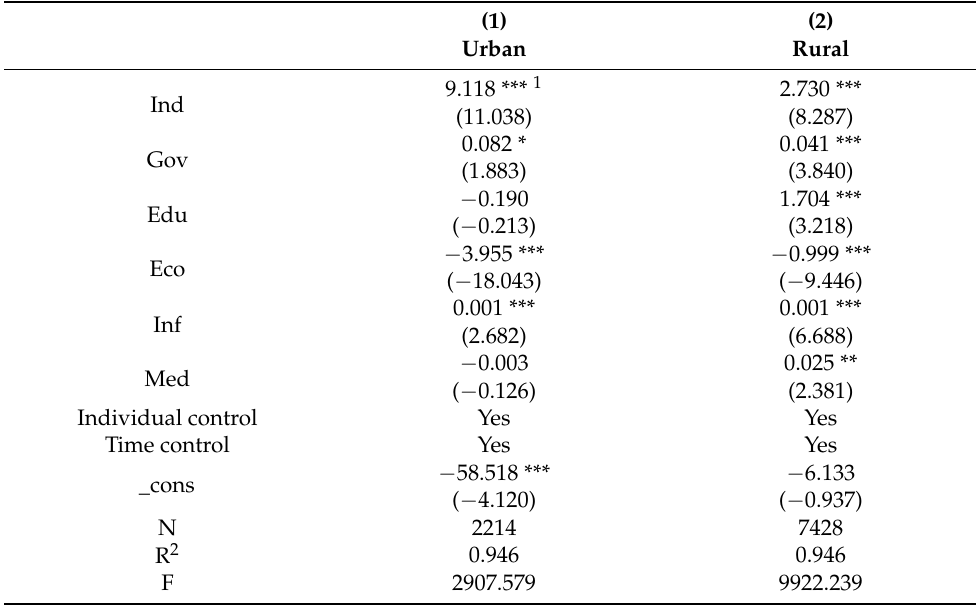
Table 3. Results of benchmark regression grouped sample of urban and rural